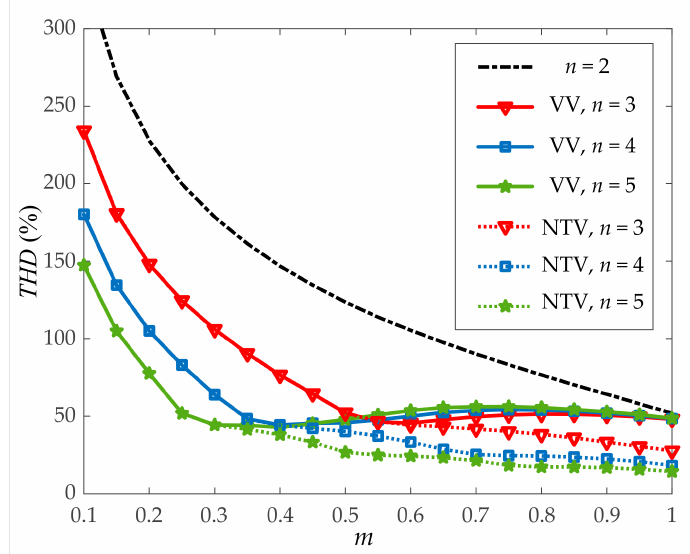
Figure 12. Total harmonic distortion of the line-to-line voltage in a three-phase multilevel NPC